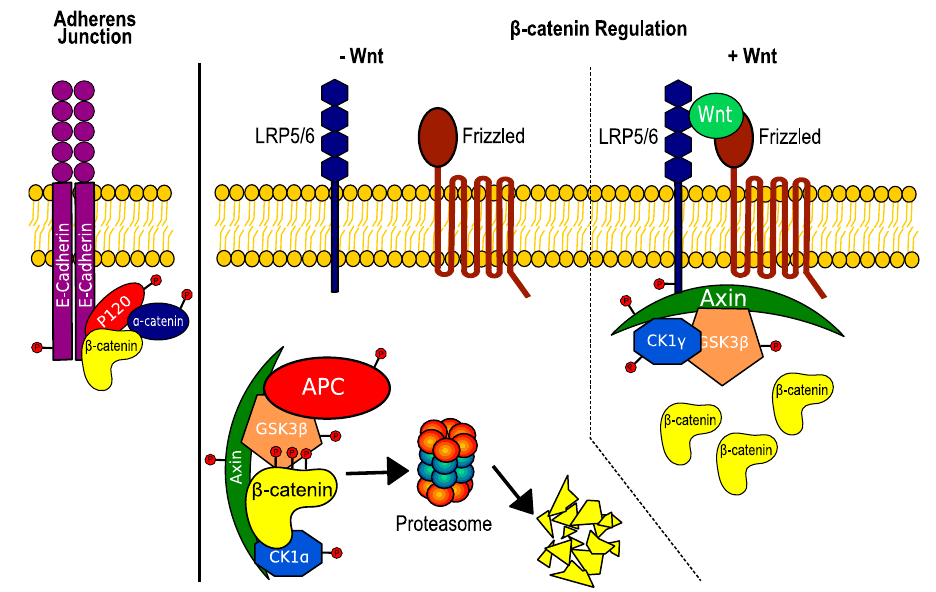
Figure 2. Phosphorylatable proteins involved in the regulation of β -catenin. Left : The adherens junction, consisting of E-cadherin, P120, and the catenins, sequesters β -catenin at the plasma membrane. Phosphorylation of E-cadherin at Ser834, Ser836, and Ser842 enhances β -catenin binding affinity, while phosphorylation at Ser846 reduces β -catenin binding. Middle : In the absence of Wnt stimulation, β -catenin is bound to the β -catenin destruction complex. CK1 α phosphorylation of β -catenin at Ser45 primes β -catenin for subsequent phosphorylation by GSK3 β at Ser33, Ser37, and Thr41, which targets β -catenin for proteasomal degradation. Phosphorylation of Axin improves its stability and subsequent ability to negatively regulate Wnt signaling. Axin and APC also contain phosphorylation sites that improve binding to β -catenin. Right : In the presence of Wnt ligand, CK1 γ phosphorylates LRP5/6, which sequesters Axin at the plasma membrane and prevents the destruction complex from phosphorylating β -catenin. CK1 α : casein kinase 1 alpha; GSK3 β : glycogen synthase kinase 3 beta; APC: adenomatous polyposis coli; CK1 γ : casein kinase 1 gamma; LRP: low-density lipoprotein receptor-related protein.